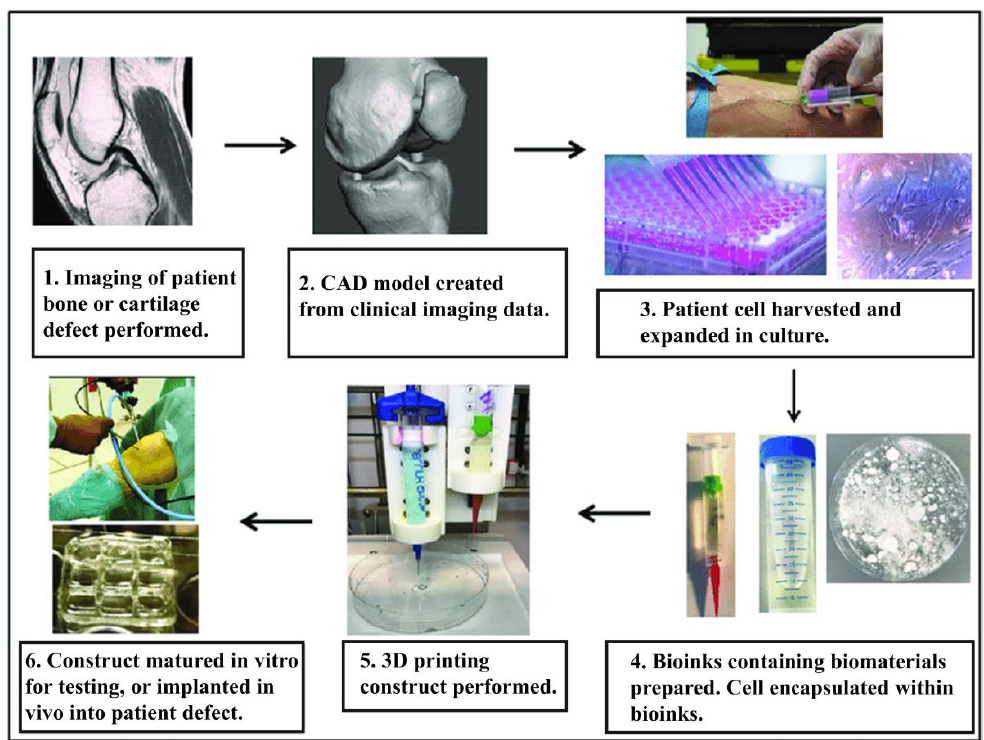
Figure 1. Three-dimensional-printing process. The image has been taken from the publication by Turnbull et al. [28] with permission.